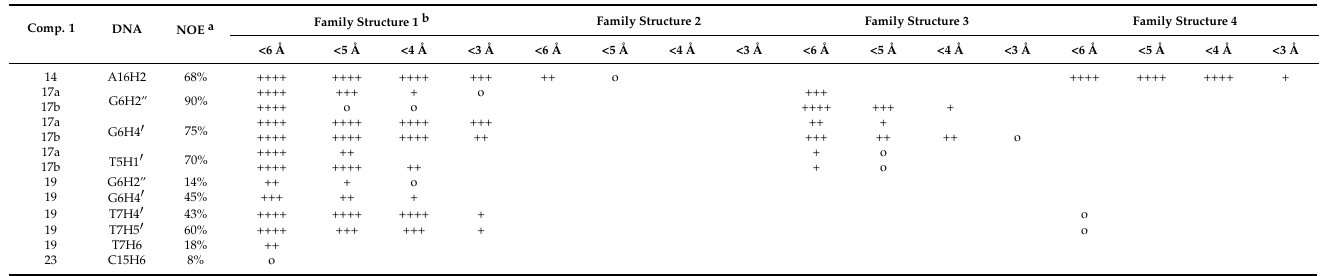
corresponding distance condition between selected protons, respectively.